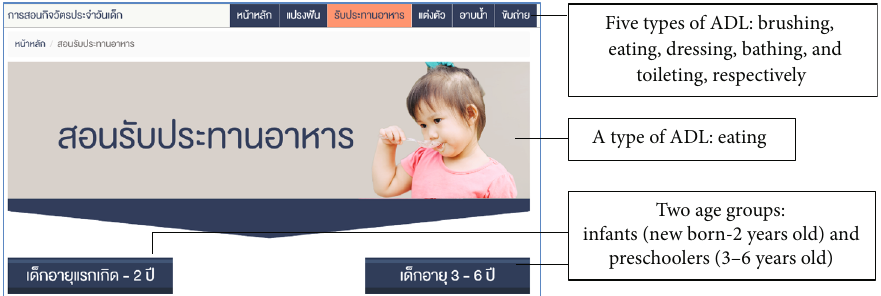
Figure 2: Two age